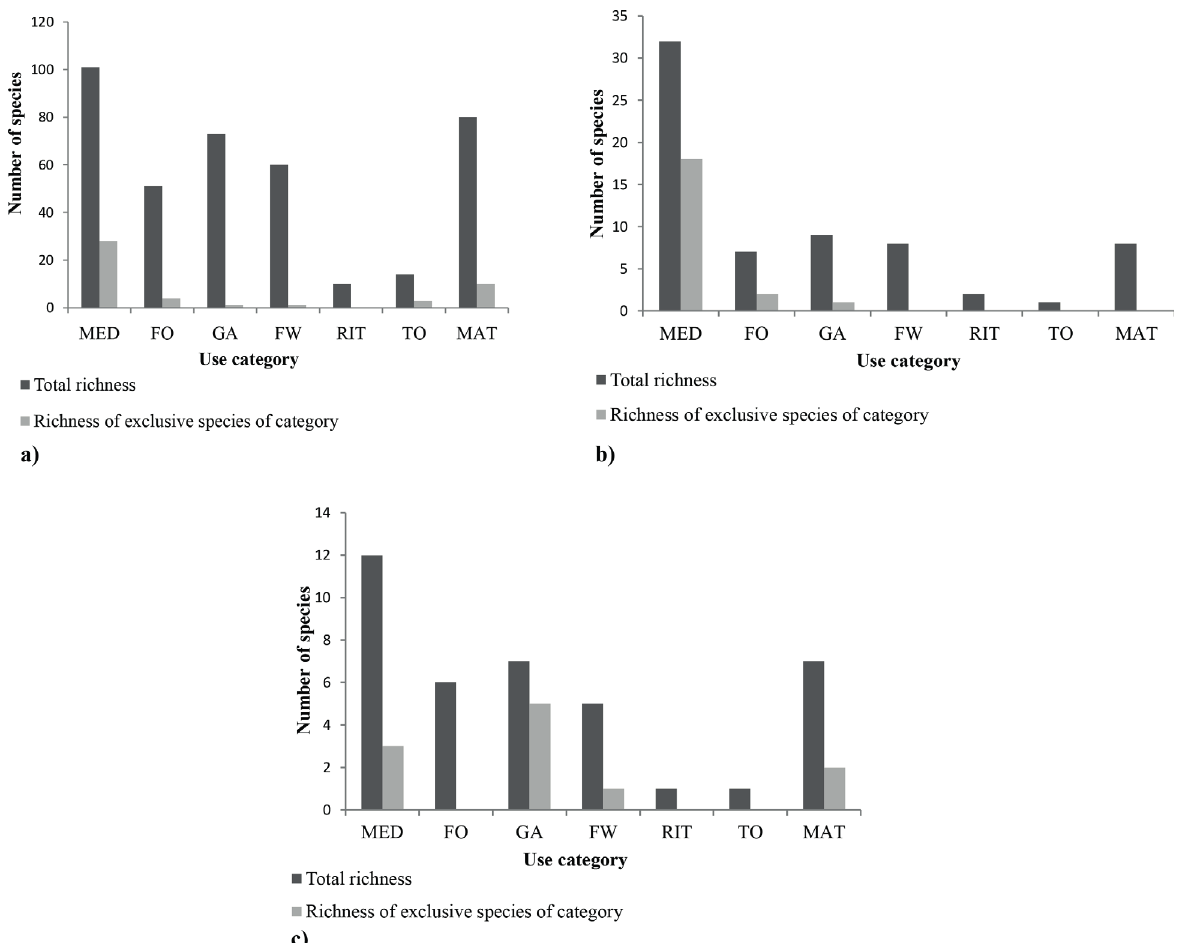
Figure 2 - Categories use of plants in differents phytophysiognomies in Serra de Carajás. a ) Forest vegetation; b ) Canga vegetation; c ) Palm